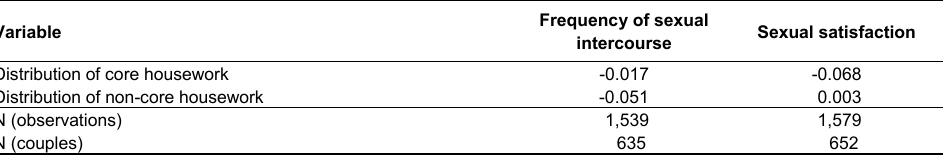
Table A.9 : Summary of fixed effects regression analyses estimating frequency of sexual intercourse and sexual satisfaction (only female partner’s